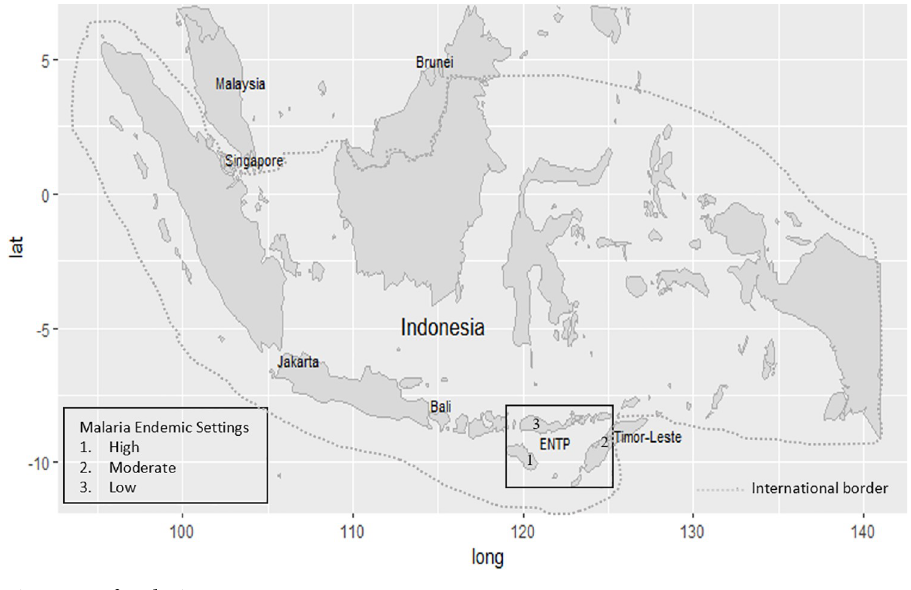
Fig 1. Map of study